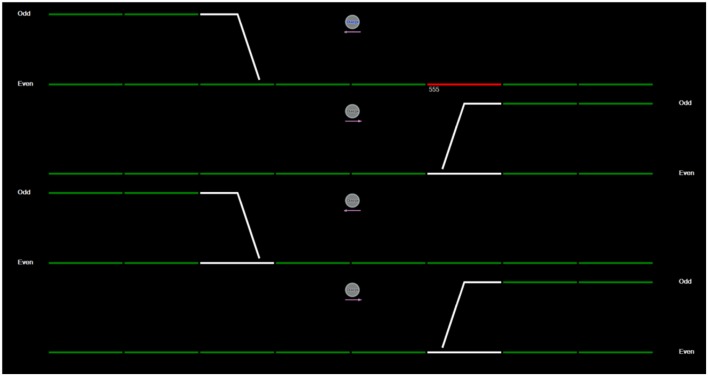
The simulated train-control display as viewed by participants. The four long, horizontal green lines represent railway tracks. The white portions on each track are the intersection lines, which are controlled by an interlocking switch labeled, “Change”. This switch is depicted by a small circle icon, located above each track. If a participant selects the “Change” icon, any train traveling on the track beneath it, will be diverted onto the intersecting line.